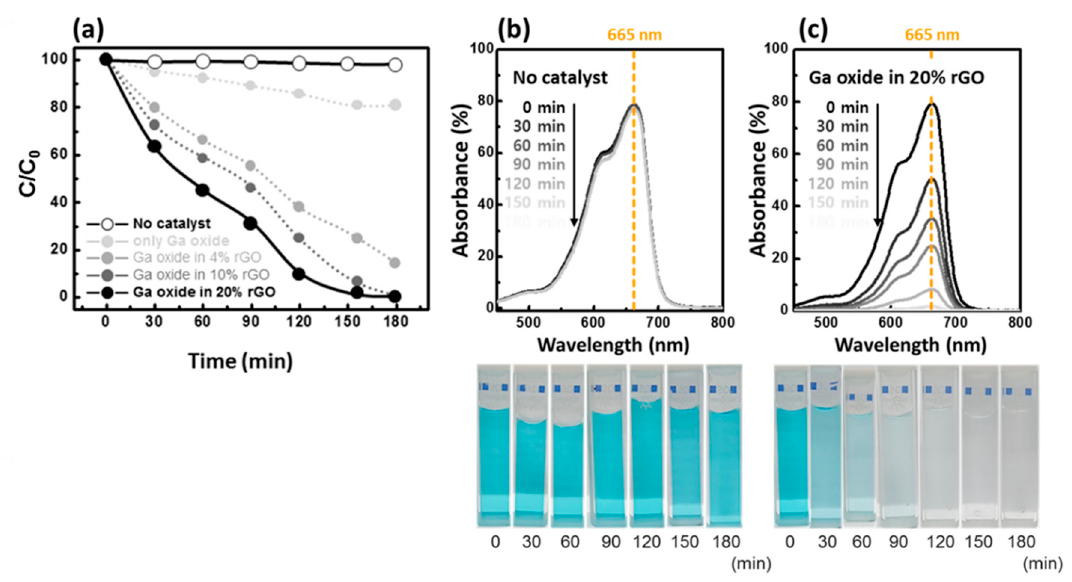
Figure 3. ( a ) MB degradation in the presence of HCs and without a catalyst at room temperature under 254 nm of radiation. The absorbance spectra of the MB as a function of time, where ( b ) No catalyst and ( c ) an HCs of Ga 2 O 3 and 20% rGO were added to the MB. The color changes of the MB depending on the level of photoelectrochemical reactions were shown in the digital photography images in the bottom of ( b , c ). For comparison, MB degradation in the presence of only rGO was also tested, which showed a similar behavior to the no catalyst (Ga oxide), indicating that rGO was not involved in the photoelectrochemical